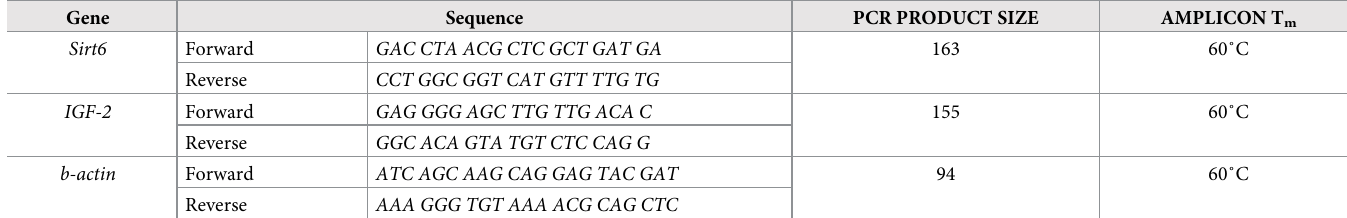
Table 3. Conditions and sequence of